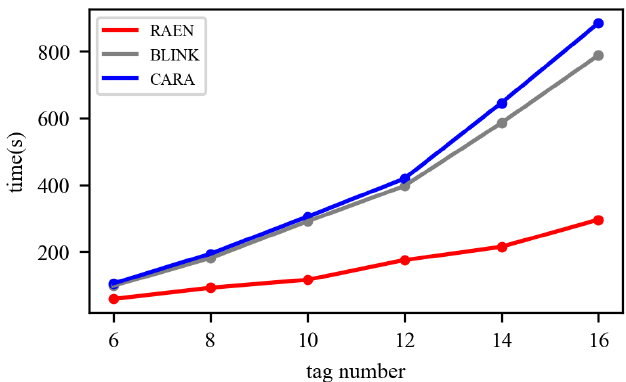
Figure 10. Efficiency of the trigger mechanism.